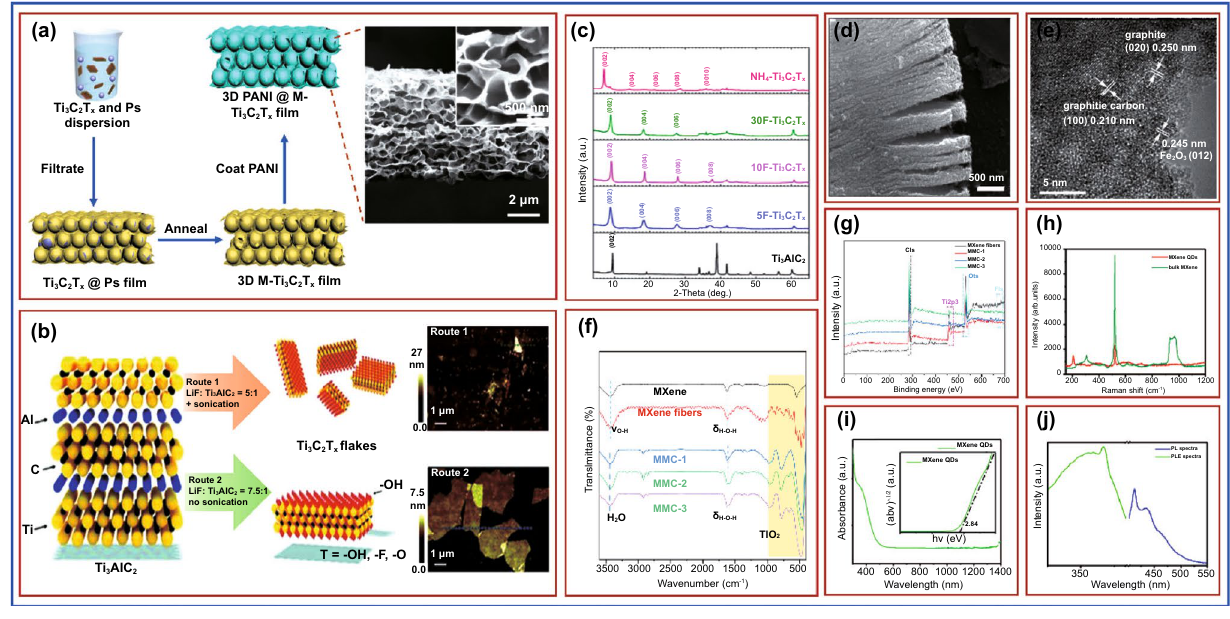
Fig. 7 a Schematic representation of the preparation of 3D macroporous PANI@M-Ti 3 C 2 T x frameworks with PS spheres as a template, inset showing SEM images of the formed 3D PANI@M–Ti 3 C 2 T x film. Copyright from Ref. [163]. b Synthesis of Ti 3 C 2 T x via two different routes with or without sonication, inset showing AFM images of the synthesized Ti 3 C 2 T x flakes. Copyright from Ref. [164]. c XRD patterns of Ti 3 AlC 2 powder and Ti 3 C 2 T x MXene powders synthesized with 5, 10, and 30%wt HF and in situ HF by using NH 4 -Ti 3 C 2 T x routes. Copyright from Ref. [165]. d The SEM image of MXenes at 500 nm. Copyright from Ref. [166]. e HR-TEM images of Ti 3 C 2 T x @FePcQDs hybrid structure. Copy- right from Ref. [167]. f FTIR spectrum, g XPS spectra of various samples. Copyright from Ref. [141]. h Raman spectra of bulk MXene and MXene quantum dots. i UV–Vis absorption spectrum of MXene QDs; the inset showing the value of the bandgap fitted. j Excitation and emis- sion spectra of MXene QDs. Copyright from Ref.